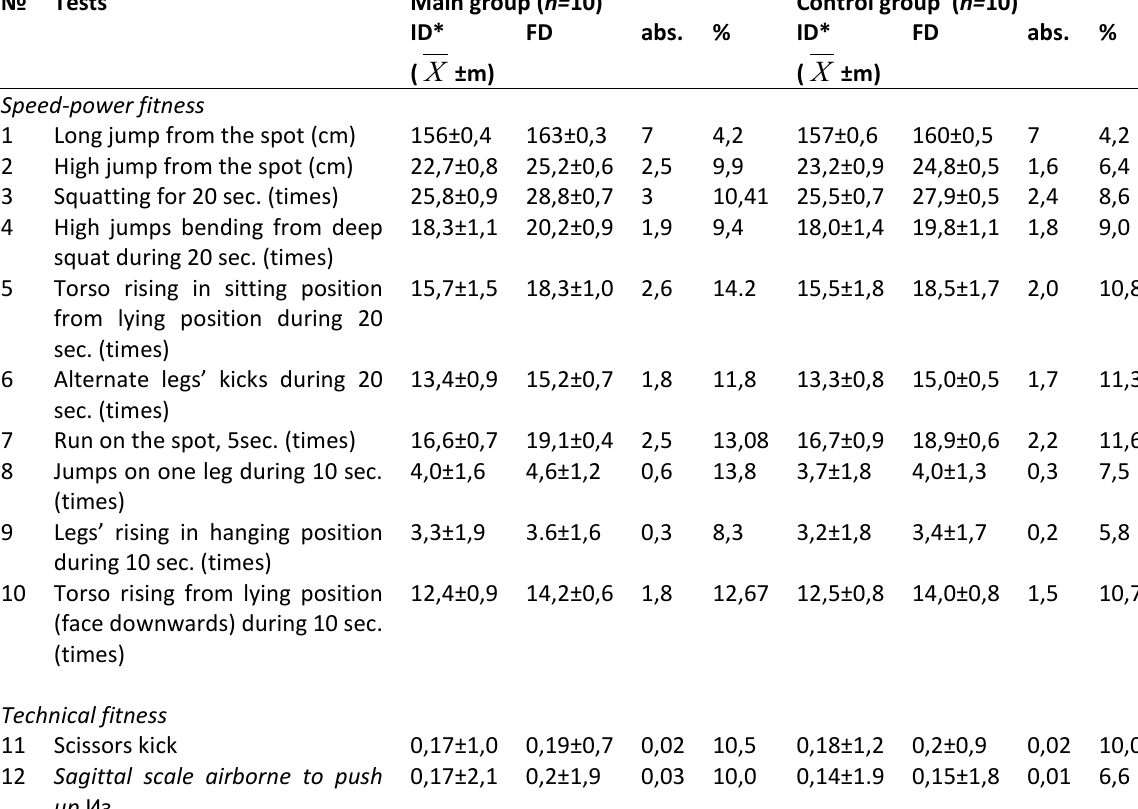
Table 1. Changes in speed-power and technical fitness in main and control groups (p